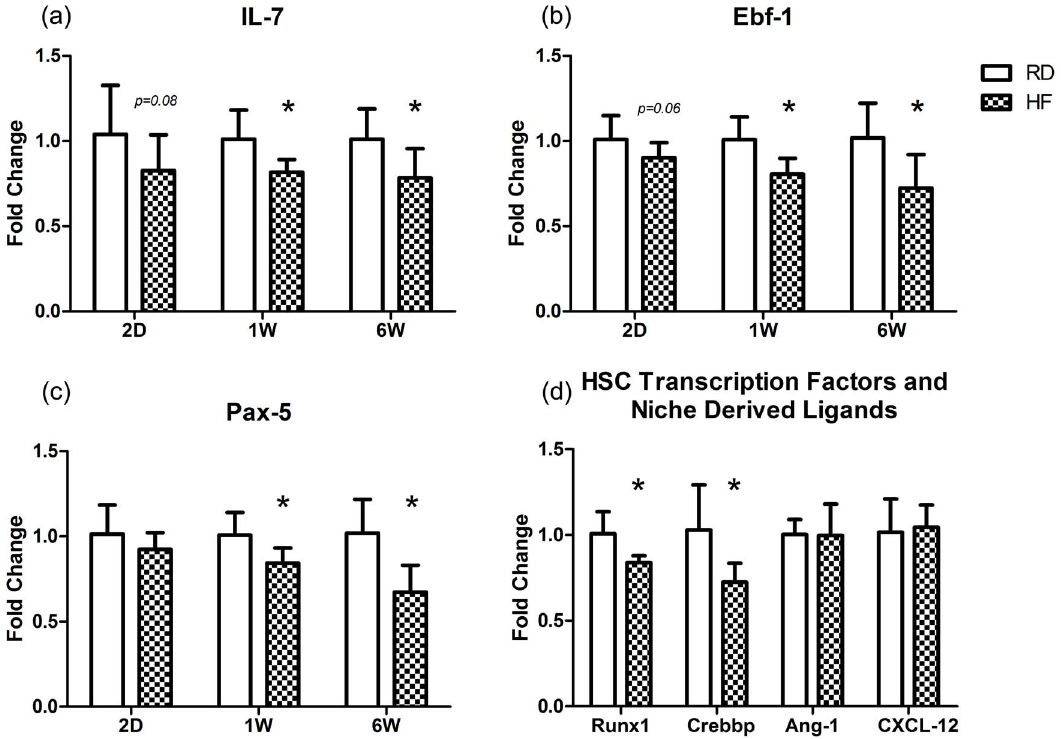
Figure 6. HFD Developmentally Decreases B Lymphopoiesis: RT-PCR was performed on whole BM extracted from the femur. (a,b) Il-7 and Ebf-1, early markers of lymphoid commitment showed strong trends of reduced expression after only 2D of HFD and were significantly reduced in HF animals from 1W onward. (c) Pax-5 expression, which represents an intermediate step in B lymphopoiesis did not appear reduced at 2D, but was significantly decreased subsequently. (d) Runx1 and Crebbp, which are critical regulators of hematopoiesis, were down regulated following 6 weeks of HFD demonstrating that obesity impacts the commitment and differentiation leukocytes as well as HSCs themselves. However, the expression of CXCL-12 and Angiopoietin-1 were not influenced by obesity (6W), demonstrating that the impact of obesity on IL-7 signaling is specific. * P , 0.05 vs. RD.